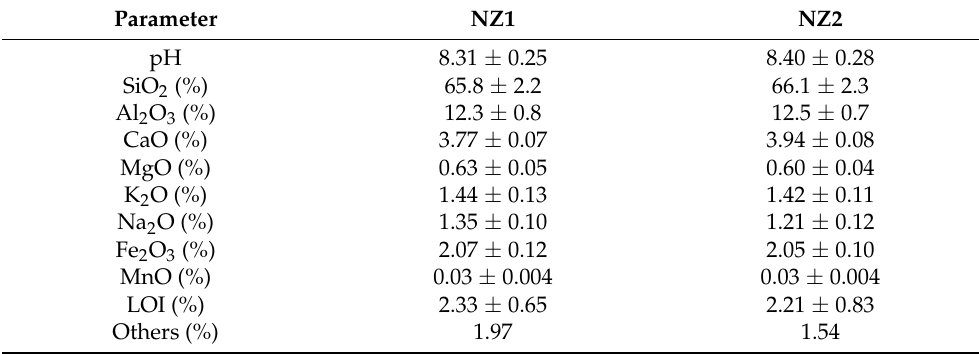
Table 1. Chemical composition of zeolitic tuff from Macicasu quarry (average value ± stdev. ( n = 3 parallel